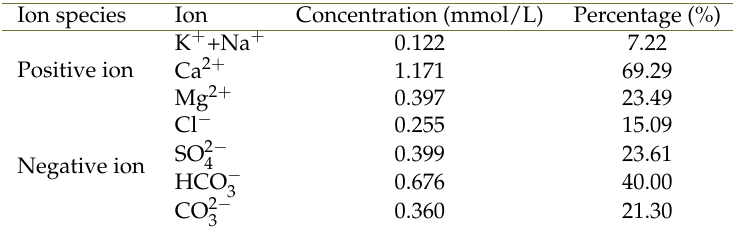
Table 1. Water quality test results.